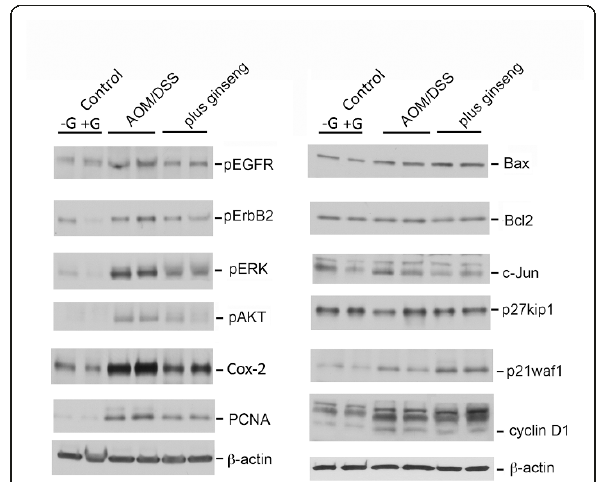
Figure 3 Ginseng inhibits EGFR signals and Cox-2 up- regulation and increases pro-apoptotic Bax in AOM/DSS tumors . Control mucosa (-G, Western diet alone, +G, Western diet + ginseng) and colonic tumors were homogenized in Laemmli buffer and indicated proteins detected by Western blotting. Shown are representative control samples and tumors from each group. Quantitative densitometry is provided in Table 2.